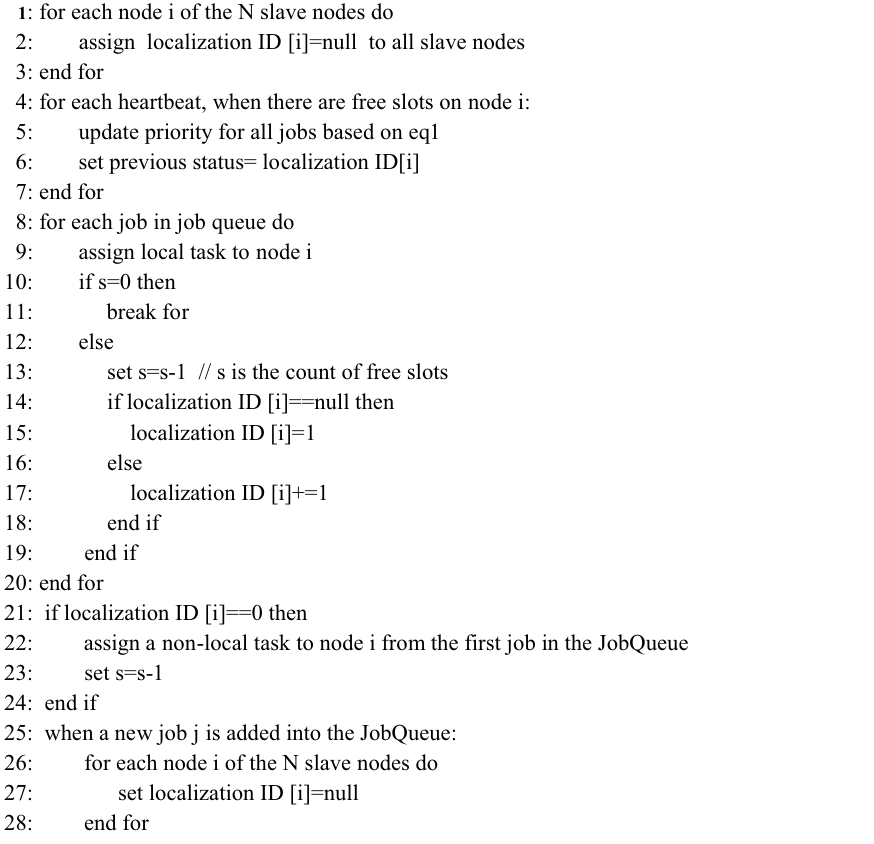
Algorithm 2 Pseudocode of HybSMRP